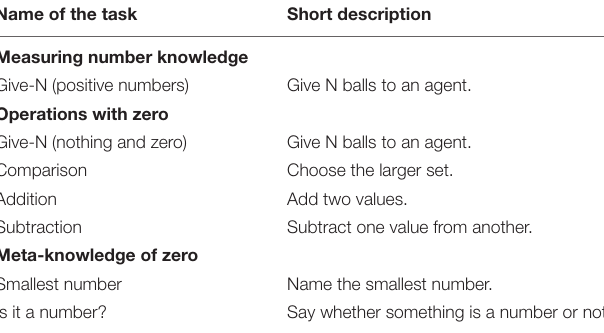
TABLE 1 | Summary of the